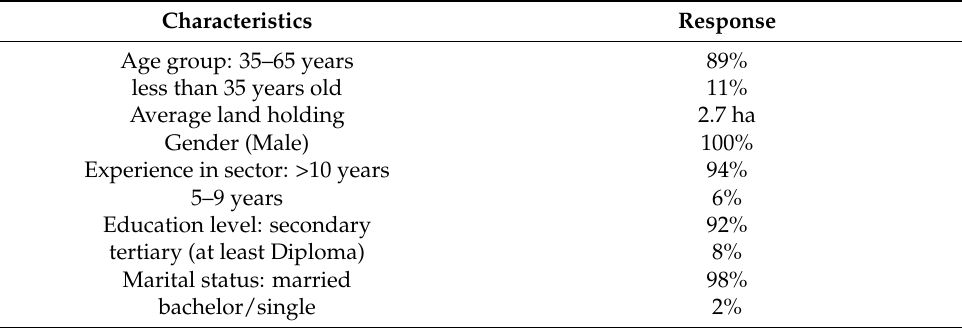
Table 2. Demographic Characteristics of